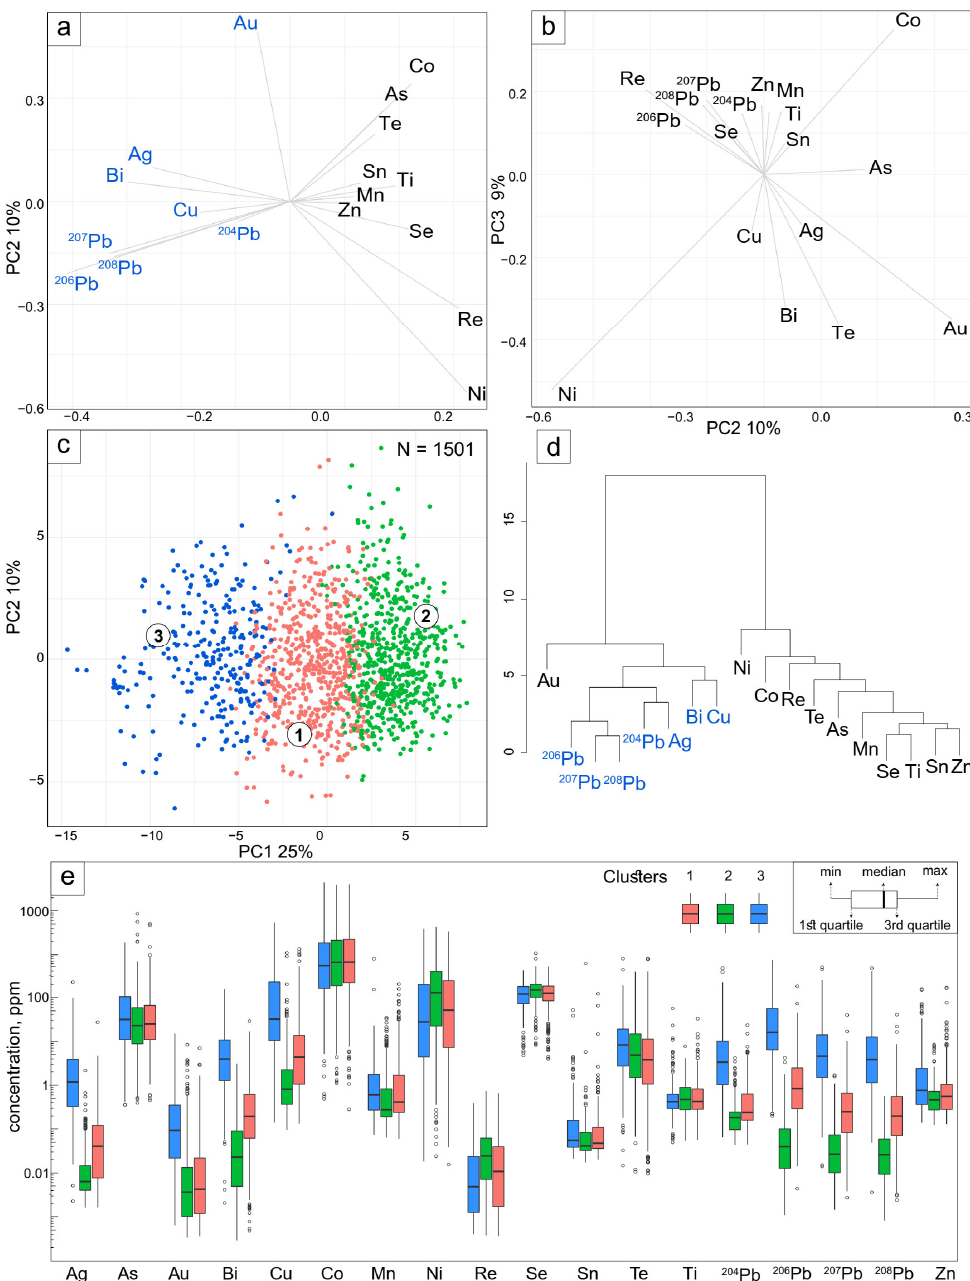
Figure 4. Principal component scores and loadings of centred log-ratio-transformed N = 1501 data. The projection of PC1 versus PC2 ( a ) and PC2 versus PC3 ( b ) shows loadings of the elements. Principal component scores are shown on the PC1 versus PC2 projection ( c ), on which each dot corresponds to an individual sample assigned to one of three clusters. Hierarchical cluster dendrogram ( d ) showing the association among the 18 elements with the height being a dissimilarity measure calculated from the variation matrix using Euclidean metrics (Table 3). ( e ) Box and whisker plot showing a range of concentrations for elements within each cluster. Note the correspondence among Cluster 3 and the Pb isotopes and Bi.